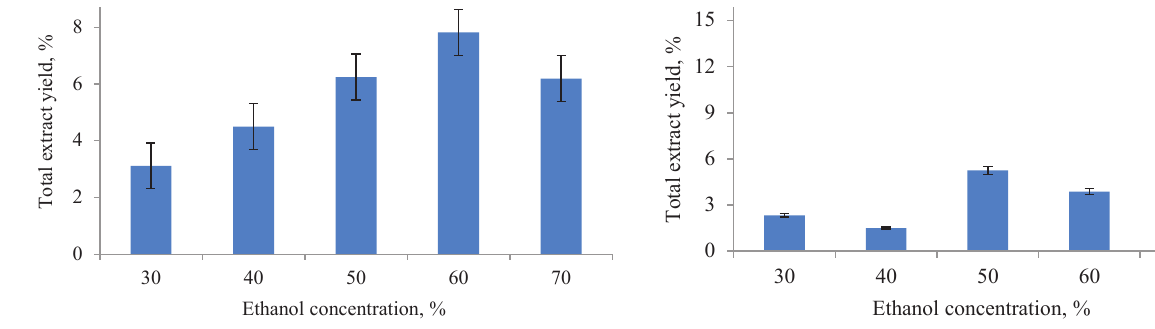
Figure 3 Solvents efficiency in extracting biologically active substances from ginseng suspension cultures